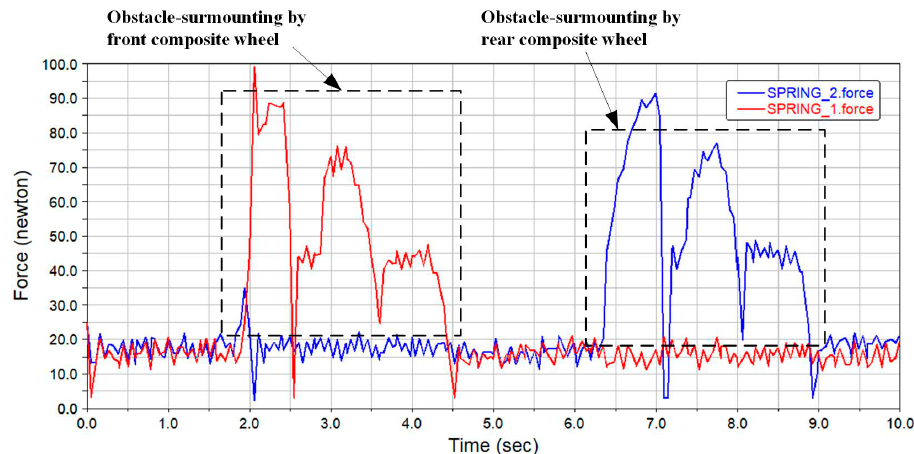
Figure 12. The simulation results of spring tension forces.